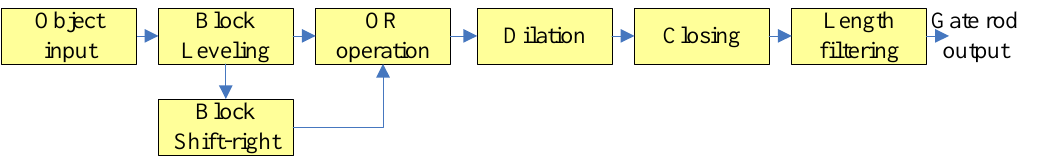
Figure 8. The gates extraction process: ( a ) the background image; ( b ) input test